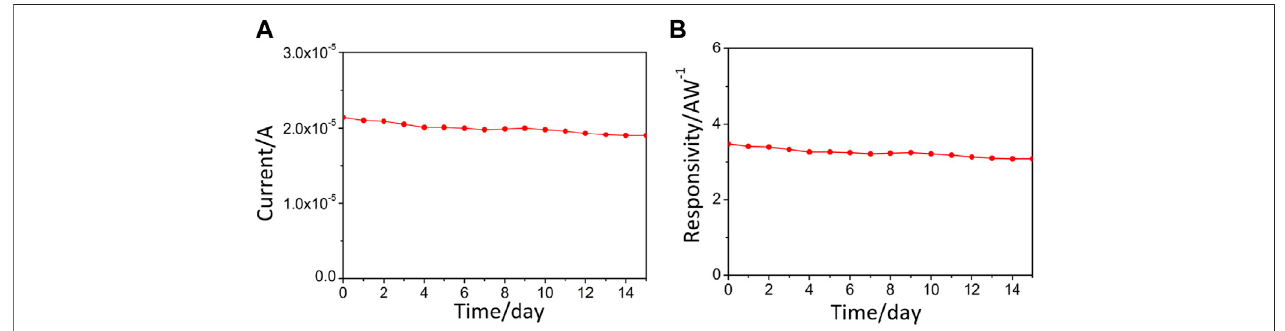
FIGURE 4 | Long-term stability of the SIPF-based PD. (A) photocurrent and (B) responsivity changing with time.